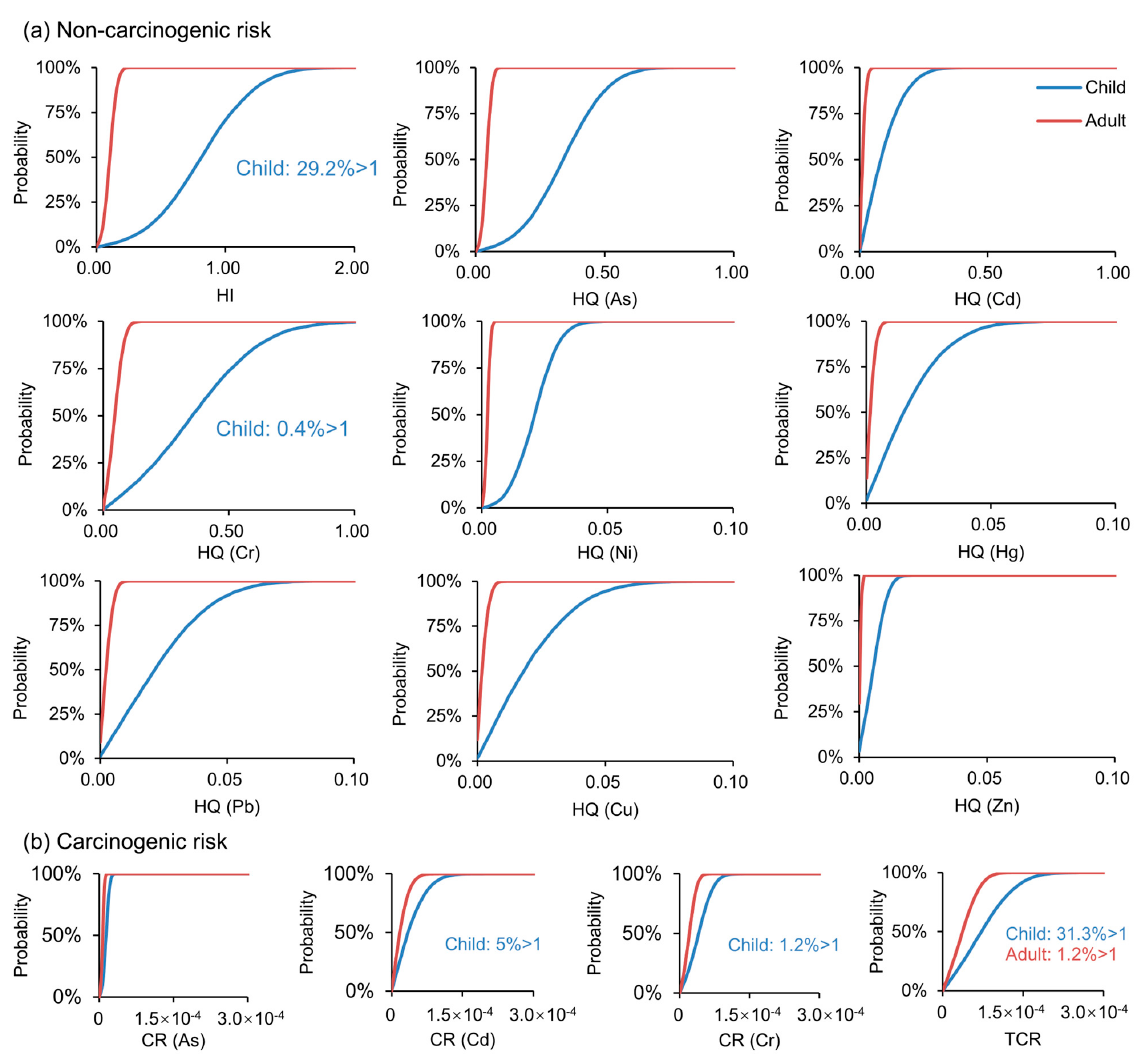
Figure 9. Cumulative probability of non-carcinogenic and carcinogenic risks. ( a ) Non-carcinogenic risk, ( b ) Carcinogenic risk.